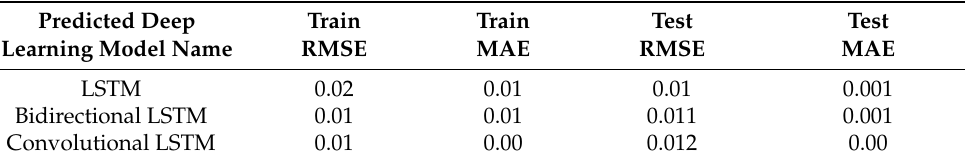
Table 3. Error comparison of LSTM, Bidirectional LSTM, and Convolutional LSTM-based prediction RMSE and